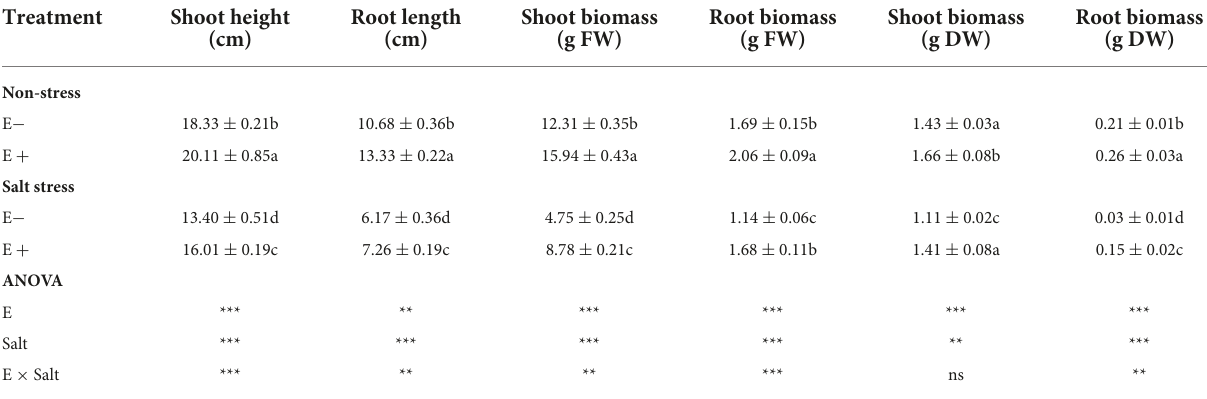
TABLE 1 Influence of Enterobacter ludwigii B30 on shoot length, root length, shoot biomass and root biomass of bermudagrass in the presence and absence of salt stress. Treatment